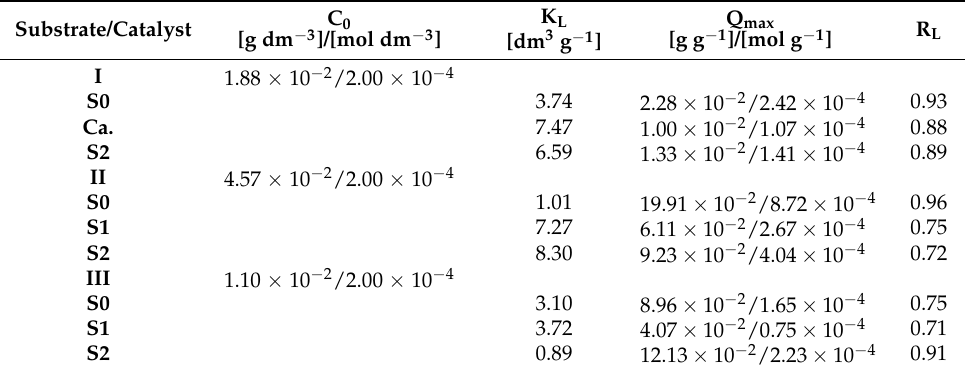
Table 3. Adsorption parameters of substrate-catalyst